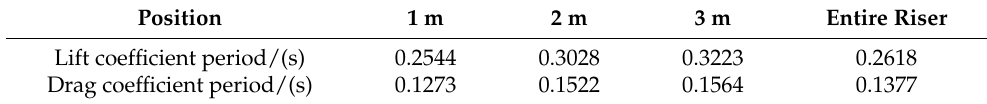
Table 3. Period of lift and drag coefficients generated by VIVs at different depths of